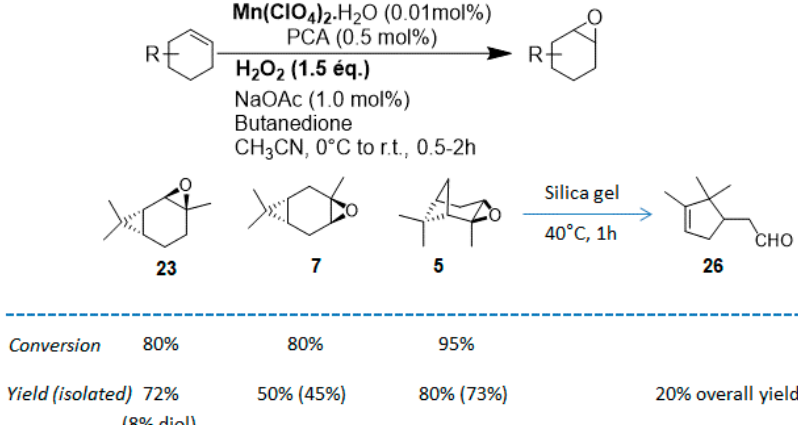
Figure 5. Oxidation of usual terpenes by an in-situ prepared Mn(II)/Pyridine-2-carboxylic acid catalyst (adapted from reference [23]).